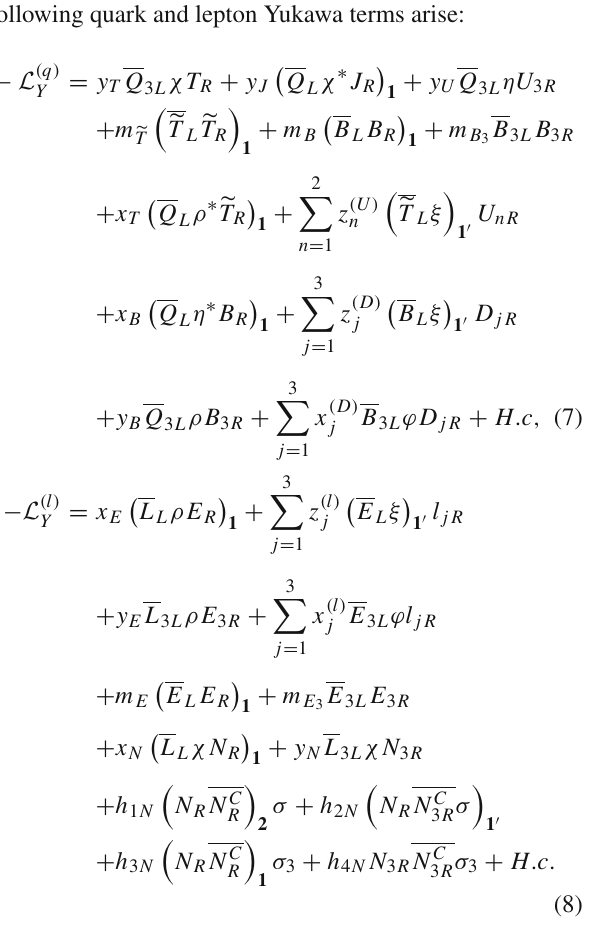
× S × Z 3 2 .Here B L , R g